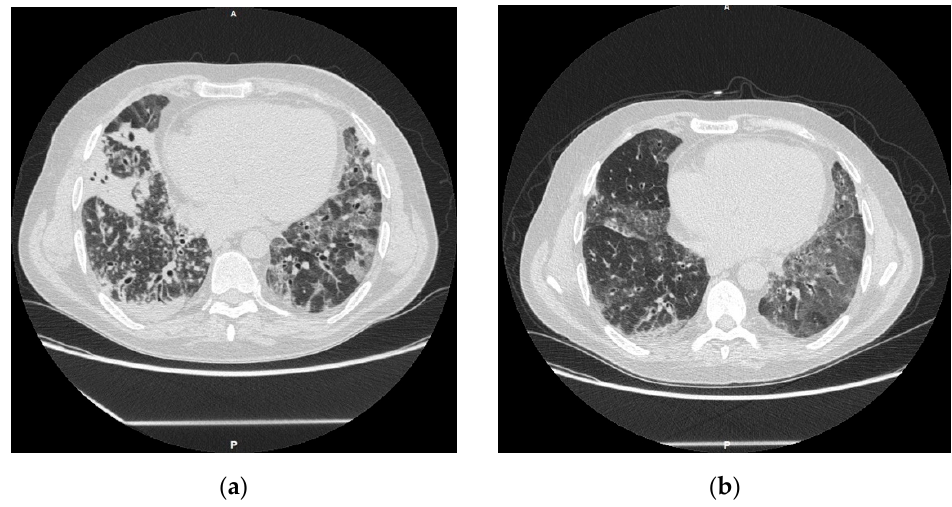
Figure 1. ( a ) Presentation CT scan of Case 1; ( b ) CT scan after antifungal treatment.